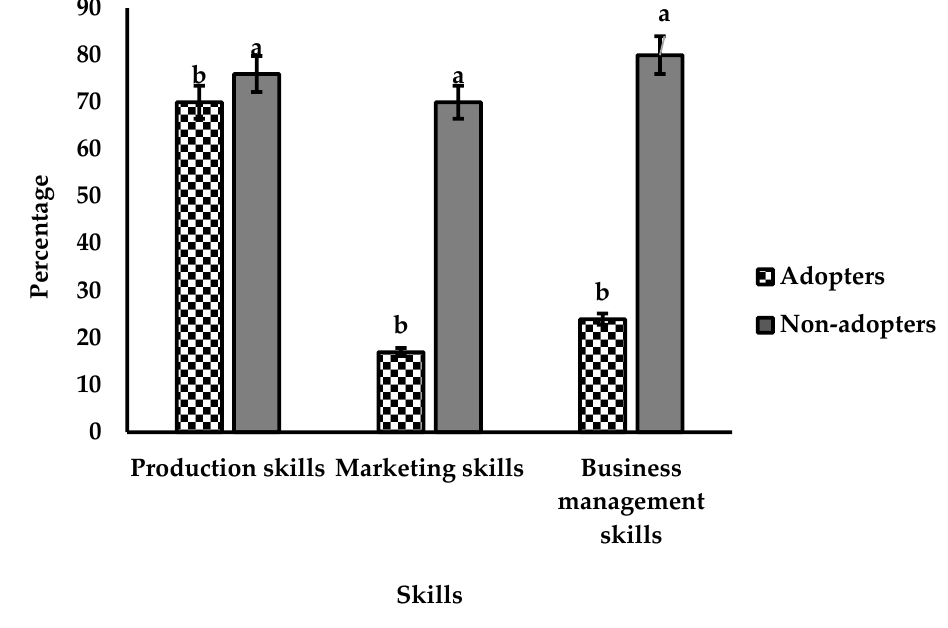
Figure 5. Assessment of SHF skills in agricultural production.